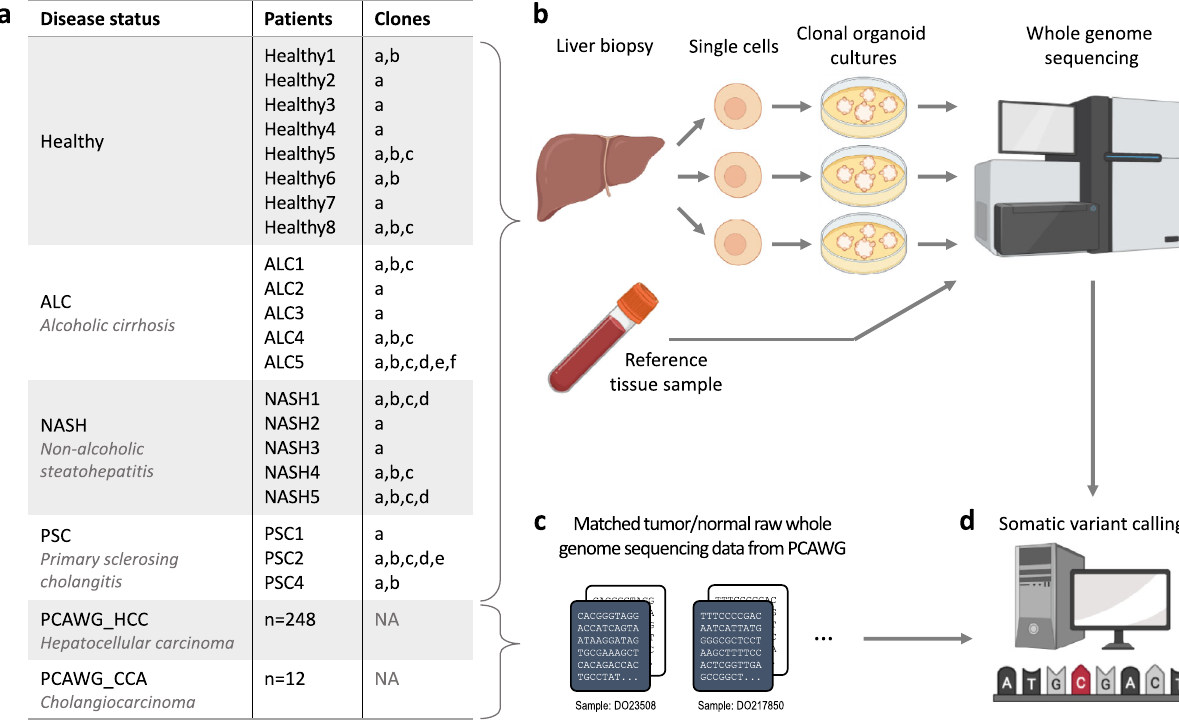
Fig. 1 Samples and experimental setup. a Summary of the samples used in this study. b Liver biopsies were taken from patients with diseased livers from which clonal intrahepatic cholangiocyte stem cell-based organoid (ICO) cultures were generated. Organoid clones were subjected to whole-genome sequencing (WGS) together with a matched tissue reference sample per patient for subtraction of germline mutations and thus detection of somatic mutations. c To compare the mutation pro fi les in liver disease versus HCC and CCA, WGS data from primary tumor samples from the Pan-Cancer Analysis of Whole Genomes (PCAWG) consortium were also included. d Somatic variant calling of diseased and cancerous livers was performed with the same